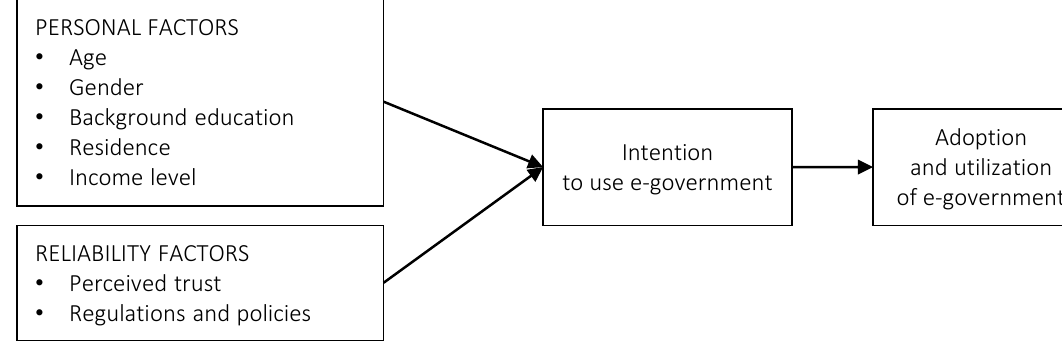
Figure 1. Research